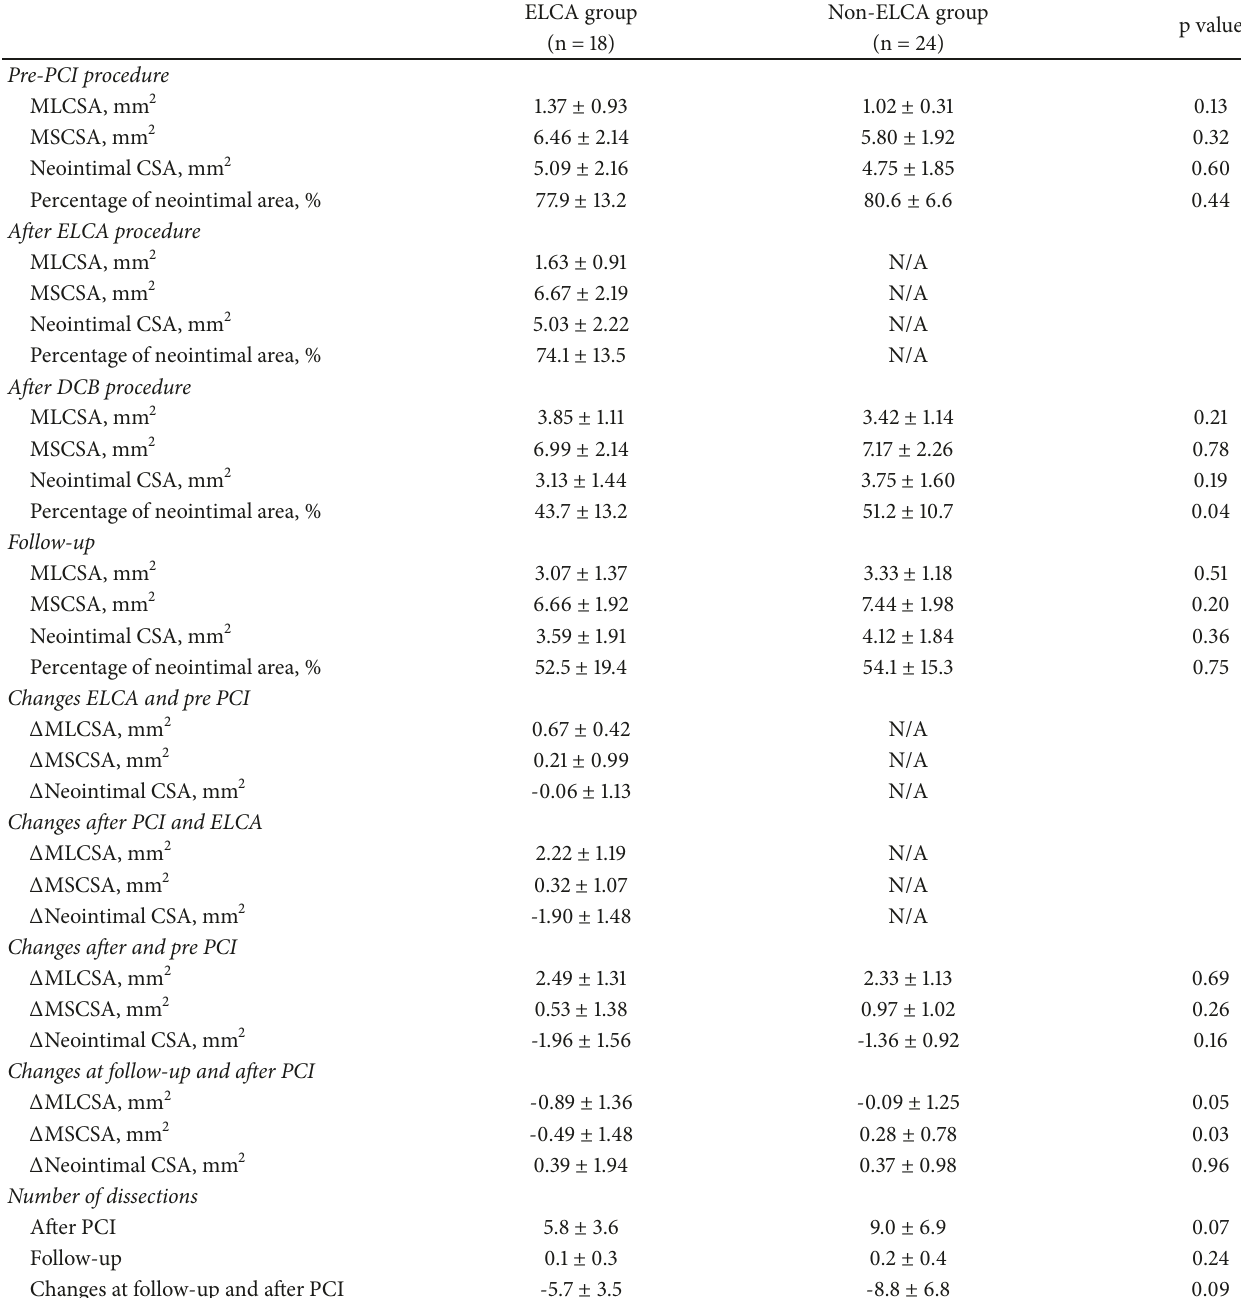
Table 3: Optical coherence tomography